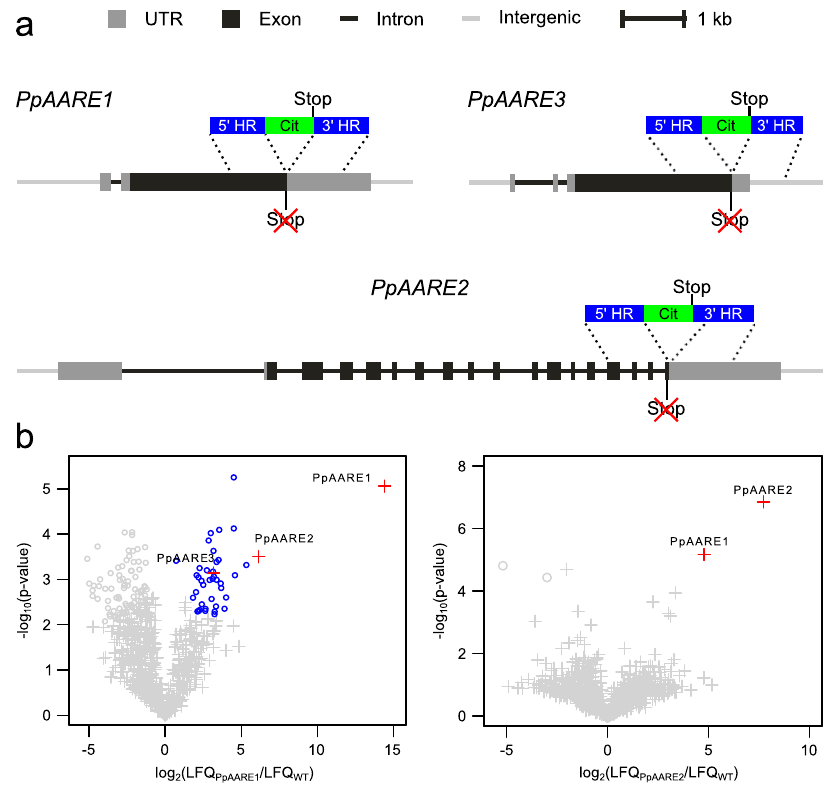
Fig. 5 Reciprocal co-immunoprecipitation (Co-IP) with Citrine-tagged PpAARE isoforms. a Tagging of PpAARE isoforms was realized by in-frame fusion with a linker- Citrine CDS at the respective native locus via homologous recombination. Original stop codons were deleted. b Volcano plots showing the result of the Co-IPs against each of the PpAARE:Citrine fusion proteins. Left panel: Pulldown of PpAARE1:Citrine. Right panel: pulldown of PpAARE2:Citrine. Co-IP was performed with GFP-Trap Magnetic Particles M-270 (Chromotek) and protonema from suspension culture. Log 2 ratios of normalized label-free quantitation values (LFQ) are plotted against – log 10 of adjusted p -values. Proteins signi fi cantly enriched in the Citrine-tagged pulldown are shown in blue circles ( p < 0.01, FDR = 0.01). Signi fi cantly enriched PpAARE isoforms are depicted as red insertion in an intron at the 5 ′ UTR, whereas the T-DNA containing the T-DNA insertion by their resistance to sulfadia- insertion in GK-456A10 (GK) maps to an intron in the region zine, and con fi rmed their genotype by PCR. In the case of the Salk encoding the catalytic domain (Fig. 6a). We obtained these line (s68), homozygous plants had lost their resistance to mutants, identi fi ed homozygous populations of GK-456A410 kanamycin, but we con fi rmed their genotype by PCR.